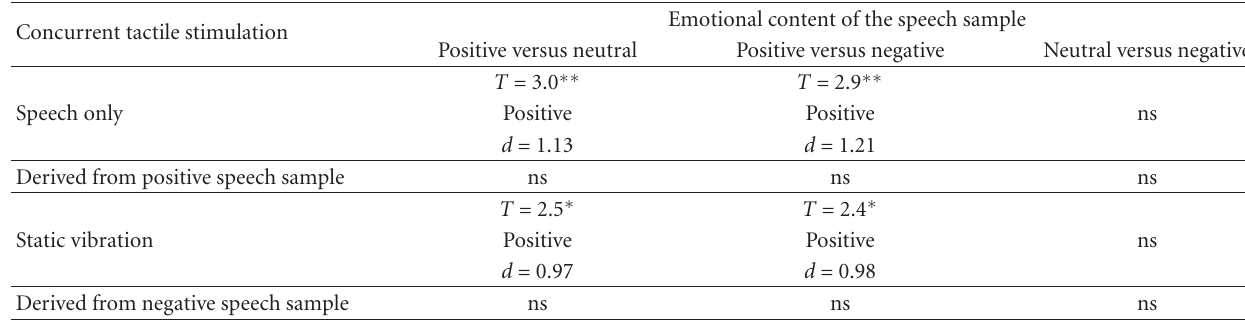
Table 4: Pairwise comparisons between the speech samples within the four concurrent tactile stimulation categories. In each cell there is Wilcoxon’s T value, stars to indicate the P value, the emotional content of the speech sample rated as more pleasant, and Cohen’s D value.